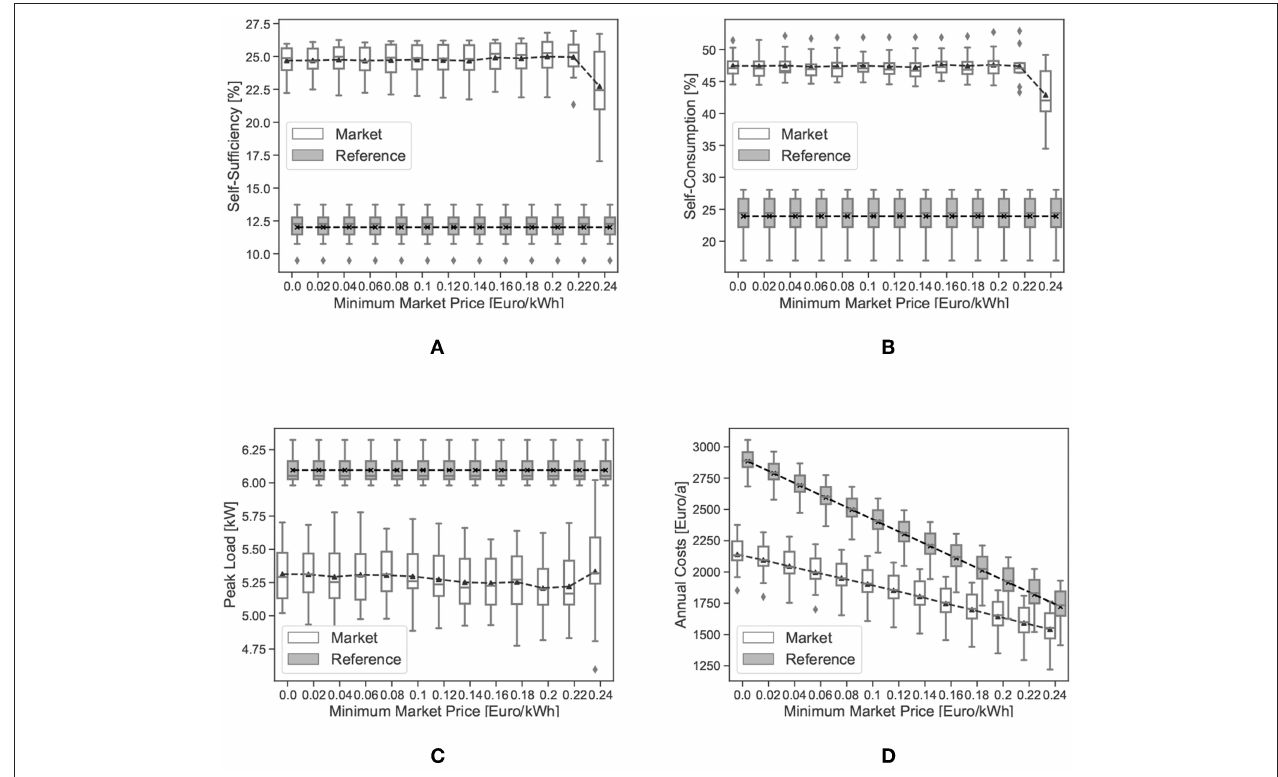
FIGURE 4 | Metrics of the scenario subgroup A1, (A) self-sufficiency, (B) self-consumption, (C) peak load, (D) annual costs.